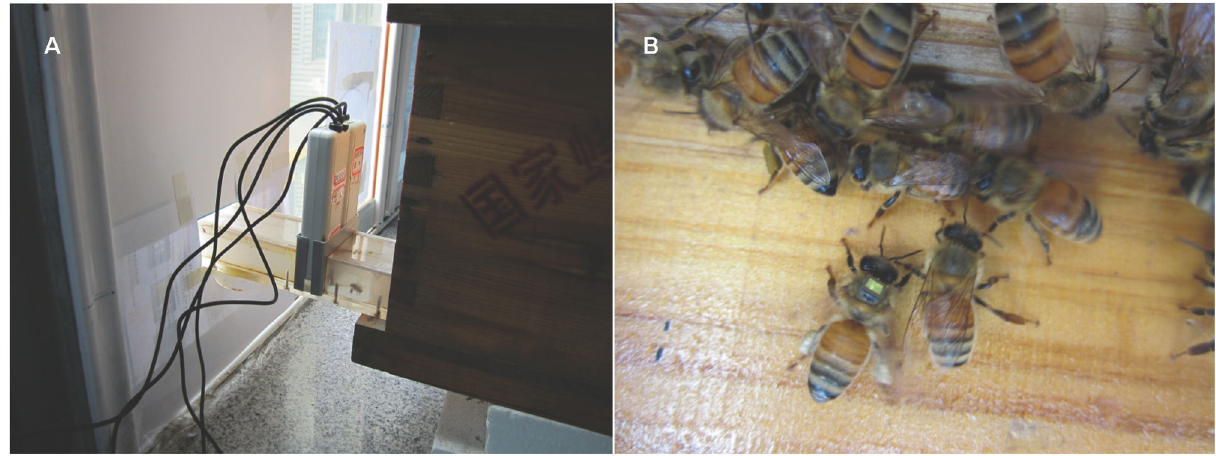
Figure 1. The RFID system used in homing experiment. (A) Two RFID readers were placed at the customized tunnel entrance of a nucleus hive with 3 frames. (B) A honey bee with the RFID tag glued to its thorax carrying pollen on its hind legs returns to the